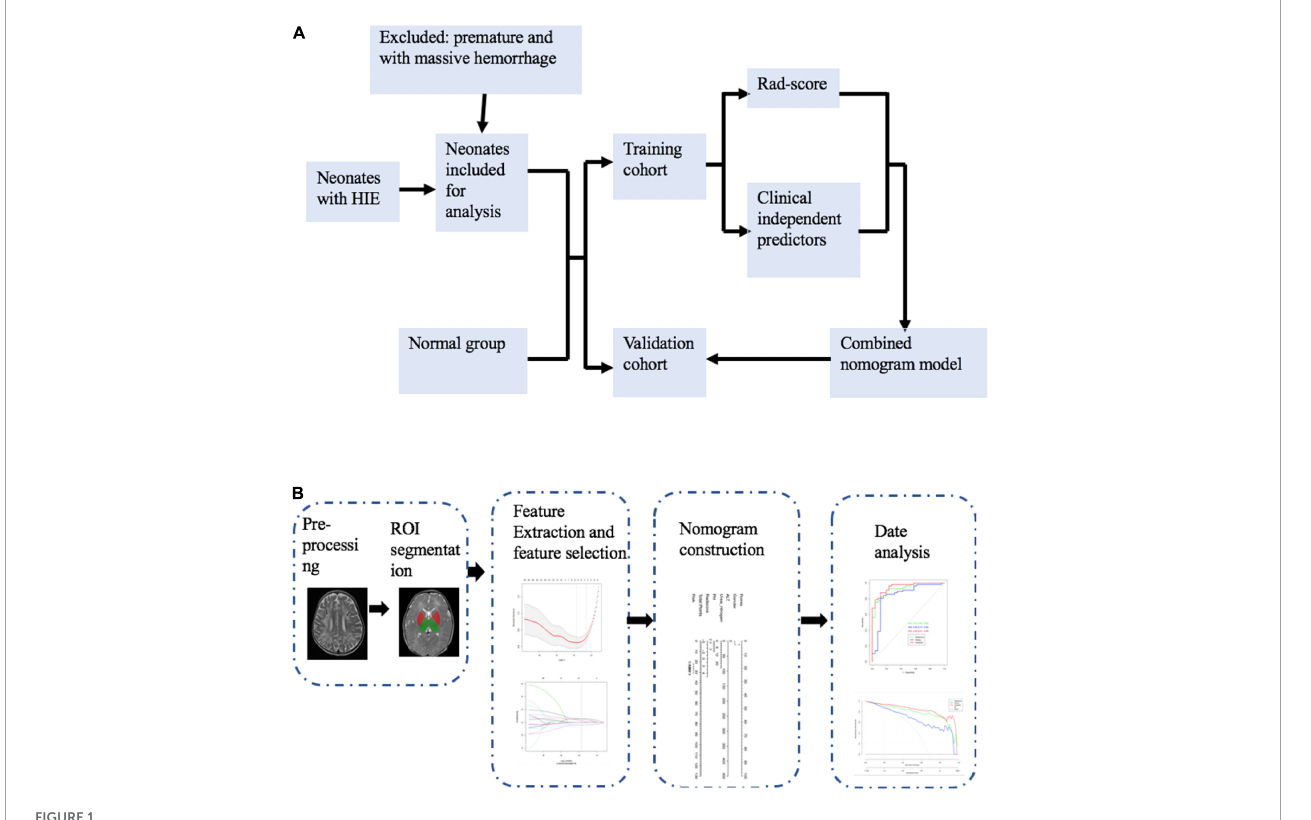
FIGURE1 Study flowchart (A) and radiomics workflow (B)